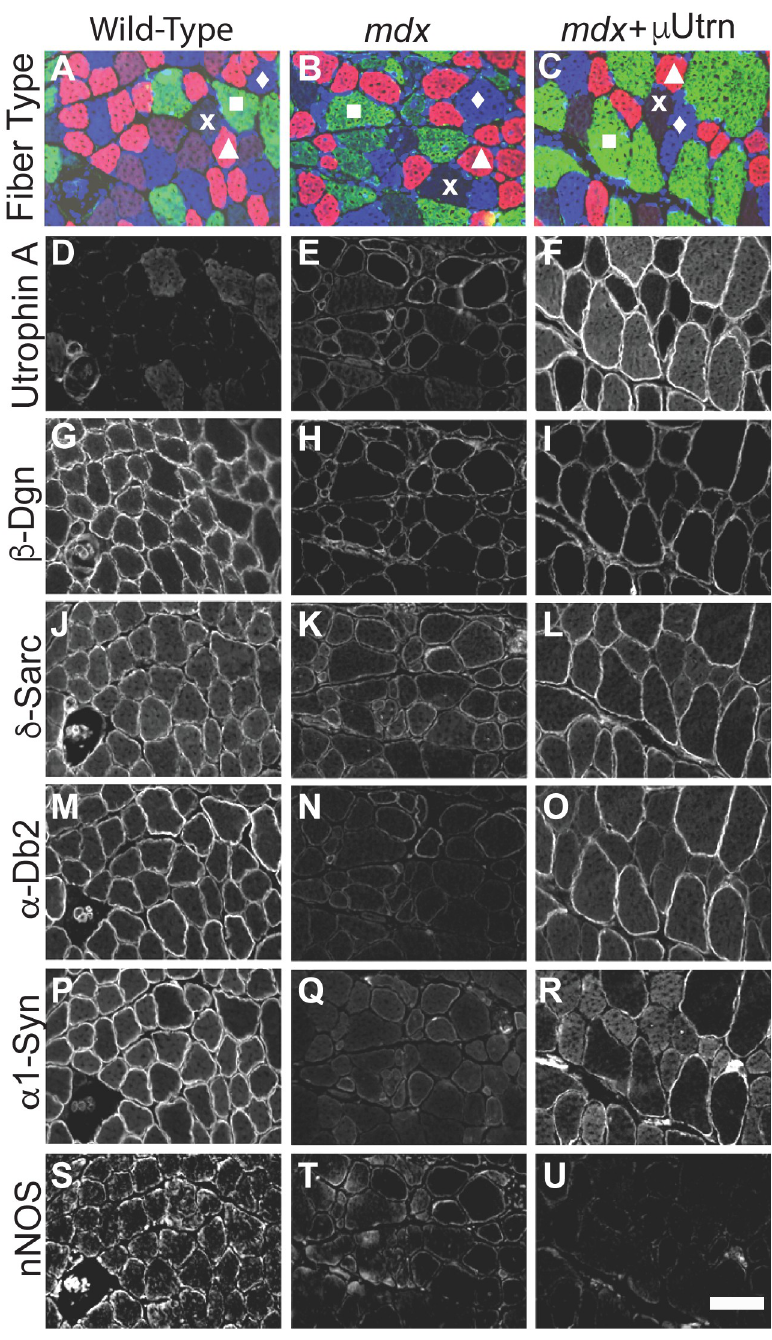
Fig 5. Restoration of DGC components α -dystrobrevin-2 and α 1 -syntrophin localization to the dystrophin- glycoprotein complex by μ Utrn expression is fiber type selective. Scale bar = 100 μ m. mdx : utrn -/- ( dko ) mice from a previous study [47]. These mice had received an intravenous injection of 2.5x10 14 vg/kg of rAAV6-CMV- μ Utrn, at 3 weeks of age and were analyzed at 4 months of age. We found no preference toward μ Utrn expression in the fast 2b fibers when compared with the 2a or 2d fiber types (S2J–S2L Fig). The status of type 1a fibers in this study